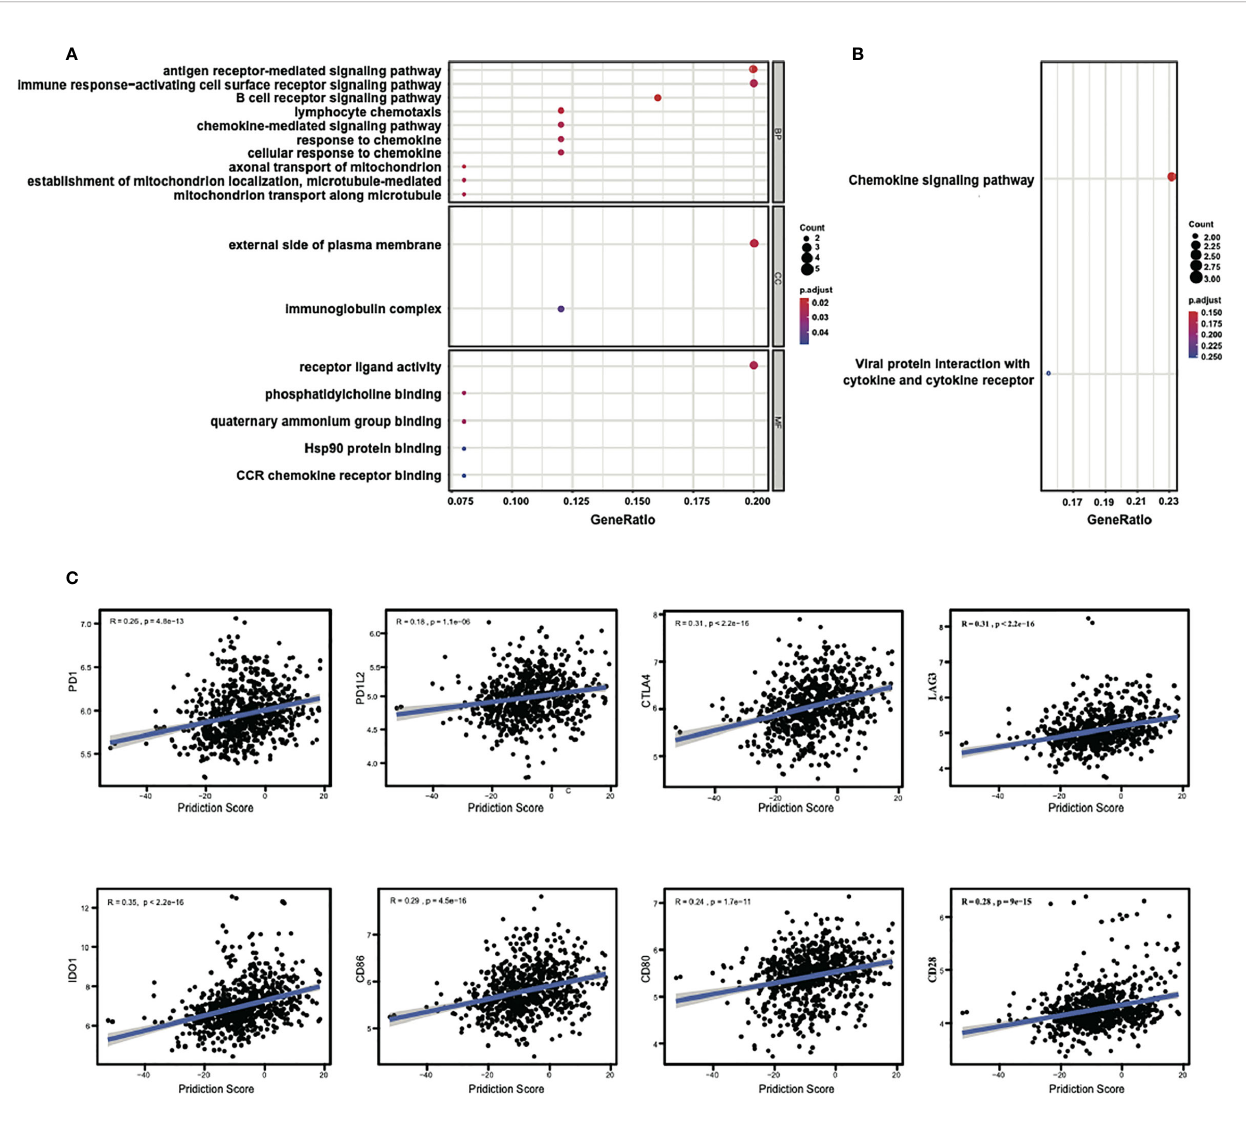
FIGURE 4 | Enrichment analysis of the 25 genes in signature and the correlations of the prediction score with the expressions of immune checkpoints. (A) Signi fi cantly enriched GO terms and (B) signi fi cantly enriched immune-related KEGG pathways. LOC102723479 is replaced with of fi cial gene symbol of IGHG1 by querying in the NetAffx Analysis Center and veri fi ed by BLAST search in NCBI database using probe sequence. (C) The prediction scores of the classi fi er show signi fi cant positive correlations with the expression of the immune checkpoints, especially with CTLA4, LAG3, and